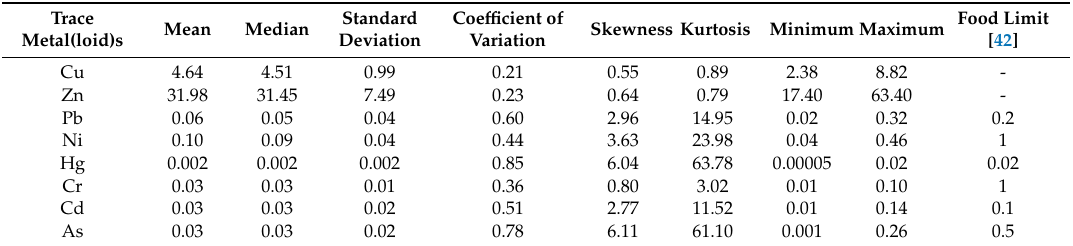
Table 4. Descriptive statistics of trace metal(loid)s in wheat in the study area (unit: mg / kg). Trace